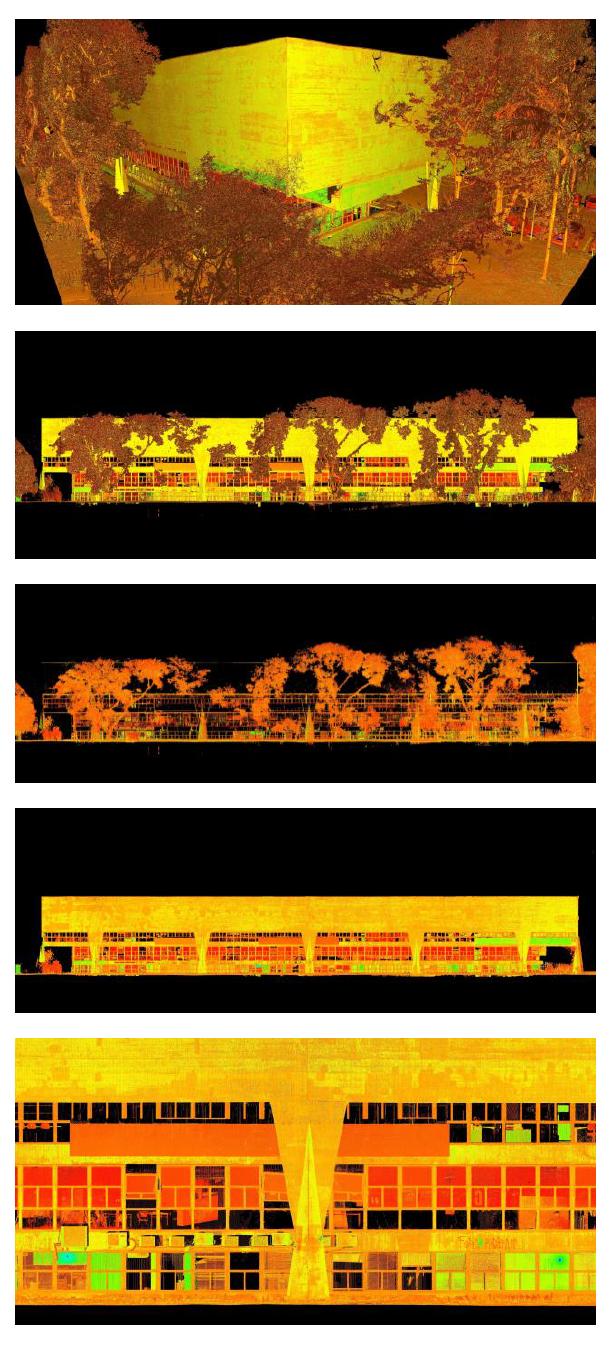
Figure 3. Different point cloud visualizations of the exteriors of the FAUUSP building